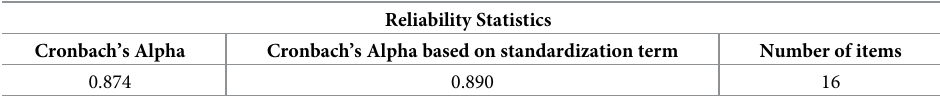
Table 1. The reliability statistics.